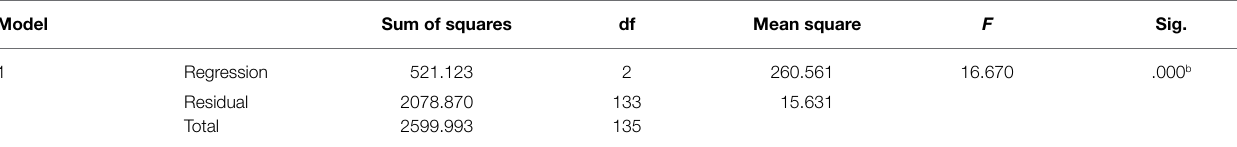
TABLE 7 | Simultaneous F -test